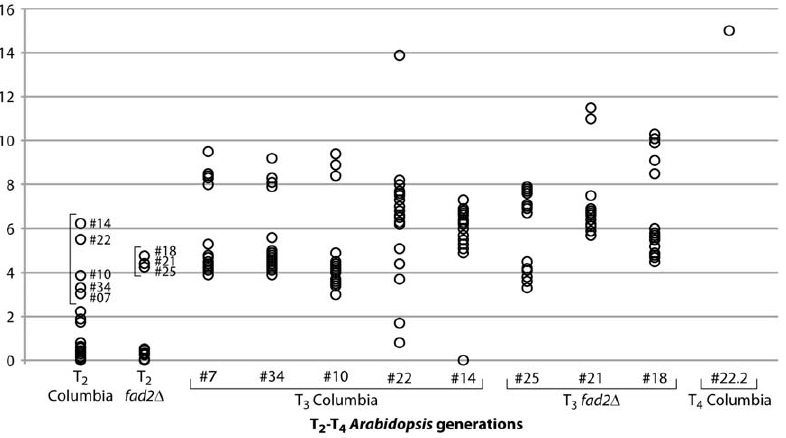
Figure 3. DHA levels as a percentage of total seed fatty acids from multiple independent transgenic Arabidopsisthaliana events in the T 2 and T 3 generations and the best T 4 event. The bracketed T 2 events were taken to T 3 . Events from both the Columbia and fad2 mutant A. thaliana backgrounds are